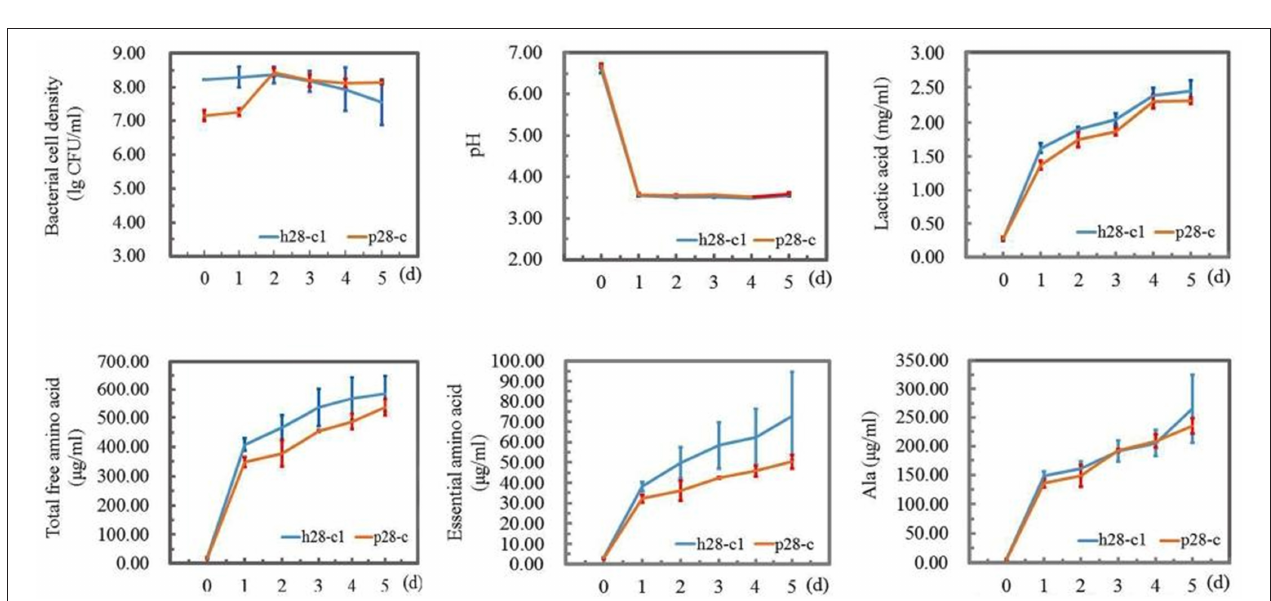
Taken together, the yeast strains could play an inhibitory role against food-borne pathogens and also provide some nutrients for the growth of other microbes (Goerges et al., 2006; Viljoen,